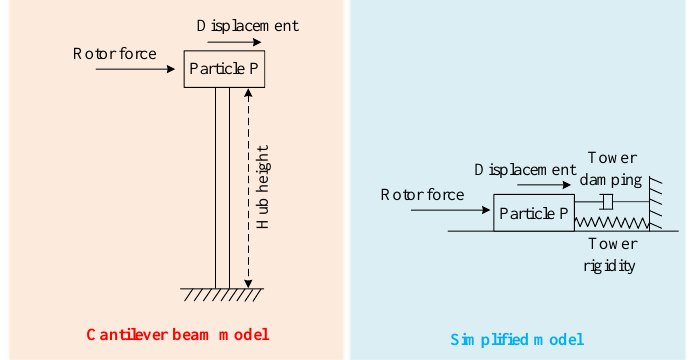
Figure 2. The typical cantilever beam model and the simplified model.